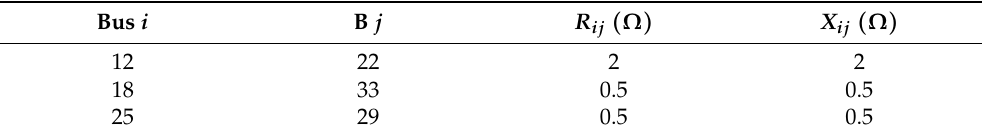
Table 3. Additional electrical parameters for the 33-bus IEEE network with a meshed structure.